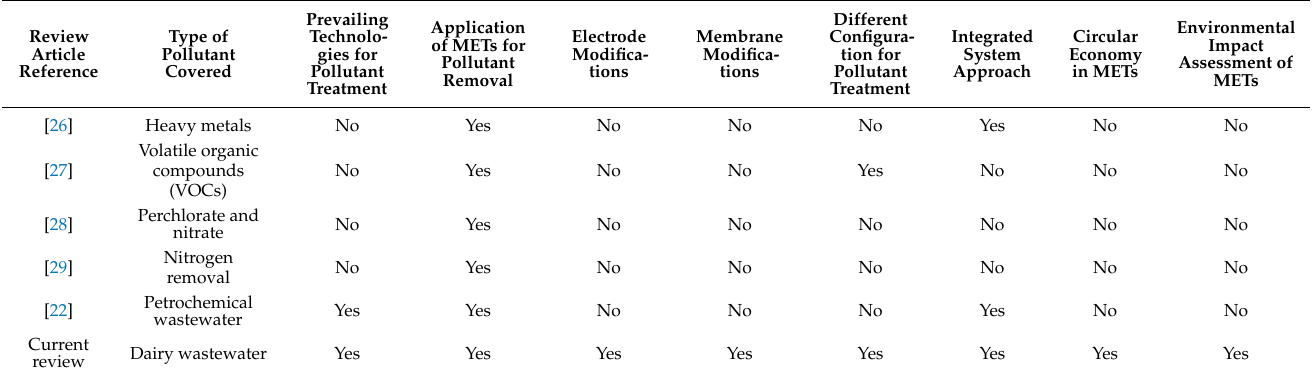
Table 1. Detailed comparison of information covered in different review articles pertaining to the treatment of different